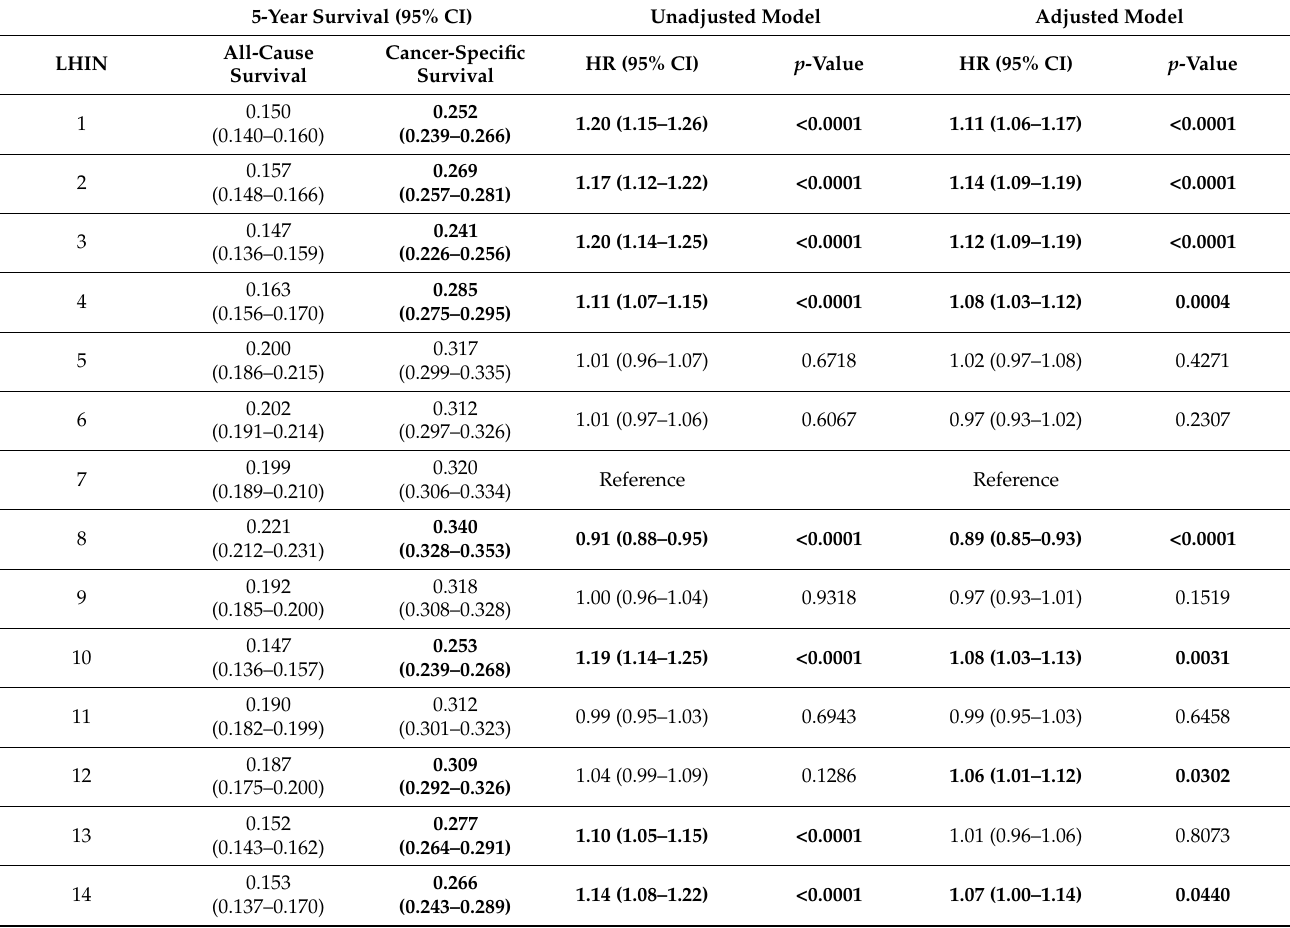
Table 5. 5-year survival and hazard ratios for cancer-specific mortality for all patients by